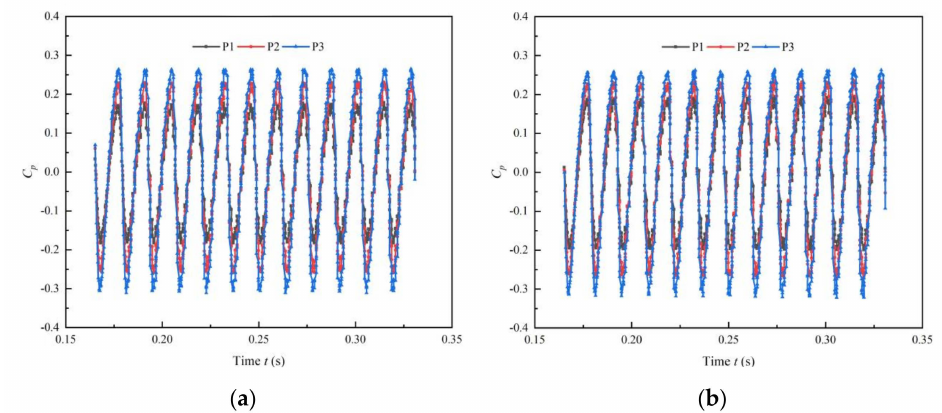
Figure 13. Time domain of pressure pulsation at impeller inlet ( Q = Q d ): ( a ) shaft front positioned tubular pump device; ( b ) shaft rear positioned tubular pump device.